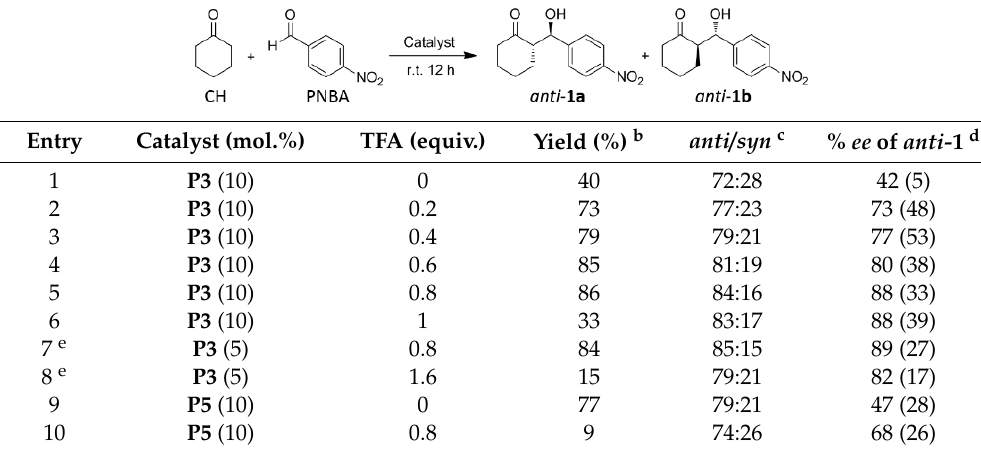
Table 2. Effect of trifluoroacetic acid (TFA) on the aldol reaction of cyclohexanone with 4- Table 2. E ff ect of trifluoroacetic acid (TFA) on the aldol reaction of cyclohexanone with nitrobenzaldehyde a 4-nitrobenzaldehyde a .